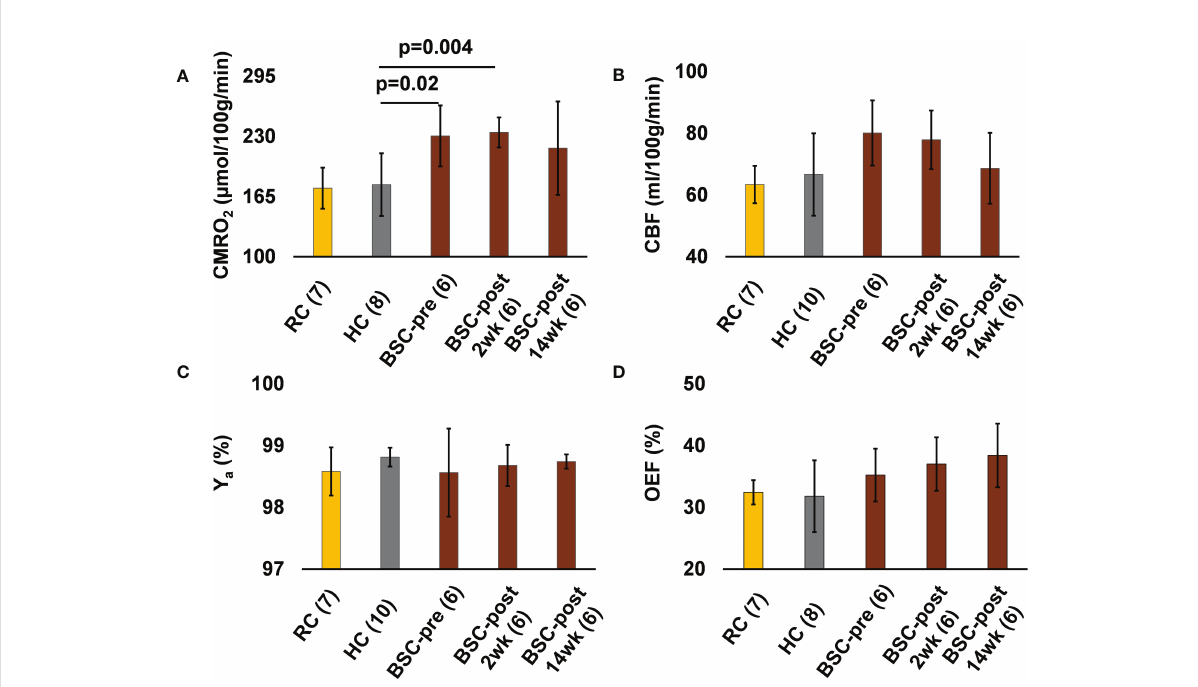
FIGURE 2 The CMRO2 (A) , CBF (B) , Ya (C) , and OEF (D) values of the young healthy weight reference controls (RC) group, healthy normal weight controls (HC) of similar age and sex as the BSC group, and the bariatric surgery candidates group before (BSC-pre), two weeks after (BSC-post 2wk), and fourteen weeks after (BSC-post 14wk) surgery. Numbers in brackets next to each group label indicates the number of participants in the